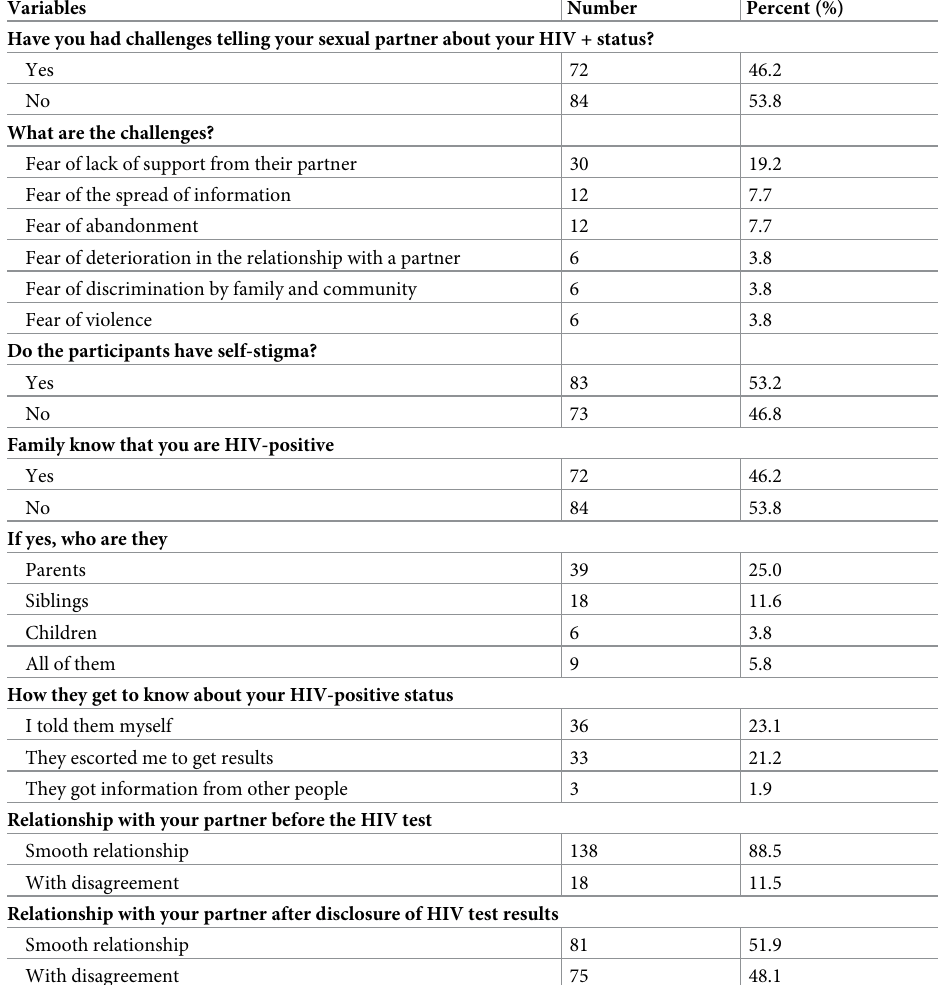
Table 3. Psychosocial factors among HIV-positive pregnant women attending ANC service in selected public health facilities in Dire Dawa, Ethiopia, 2020 (n = 156).